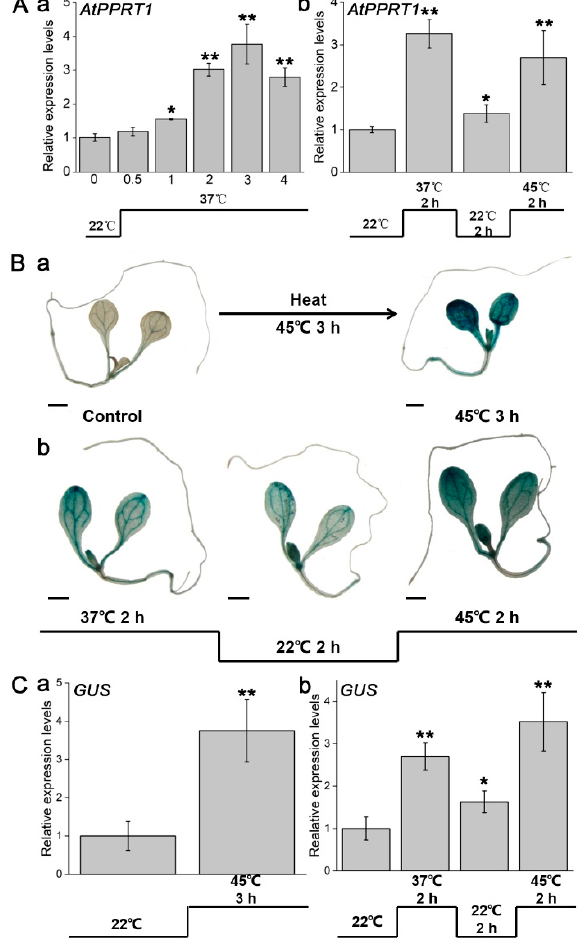
Figure 1. Expression of AtPPRT1 was induced by heat stress. ( A ) Transcript level of AtPPRT1 under ( a ) basal and ( b ) acquired heat thermotolerance. Error bars represent ± SD ( n = 3, * p < 0.05, ** p < 0.01, t -test); ( B ) 7-day-old ProPPRT1::GUS transgenic seedlings used for GUS histochemical staining under ( a ) basal and ( b ) acquired heat thermotolerance. Scale bar: 1 mm; ( C ) expression of the GUS gene under ( a ) basal and ( b ) acquired heat thermotolerance. Error bars represent ± SD ( n = 3, * p < 0.05, ** p < 0.01, t -test).